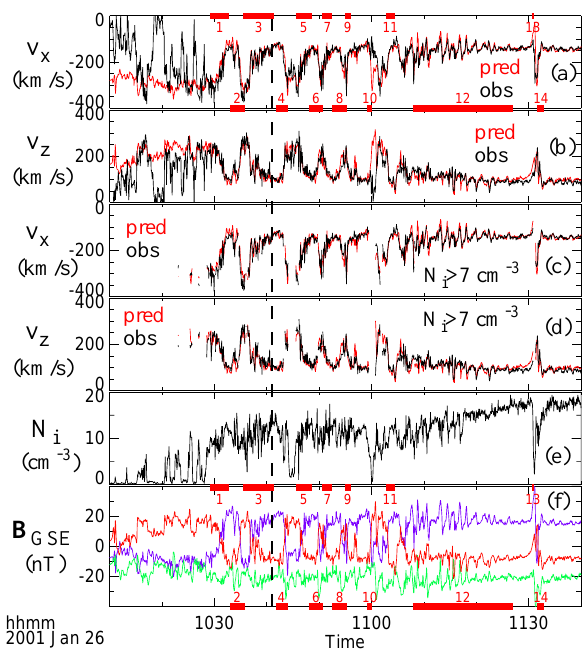
Fig. 5. Zoom-in of the 10:10–11:40UT interval. (a) – (b) x and z components of the predicted (red) and observed ion velocity, (c) – (d) Figure 5. Zoom-in of the 10:10-11:40 UT interval. (a-b) x and z same as panels (a) and (b) but for ion density > 7cm − 3 only, (e) ion components of the predicted (red) and observed ion velocity, (c-d) number density, (f) magnetic field components in GSE. The labeled same as Panels a and b but for ion density> 7 cm -3 only, (e) ion crossing numbers in panels (a) and (f) correspond to complete or number density, (f) magnetic field components in GSE. The near-complete crossings for the Wal´en test summarized in Table 1. labeled crossing numbers in Panels a and f correspond to The dashed line denotes the magnetosheath reference complete or near-complete crossings for the Walen test summarized in Table 1.